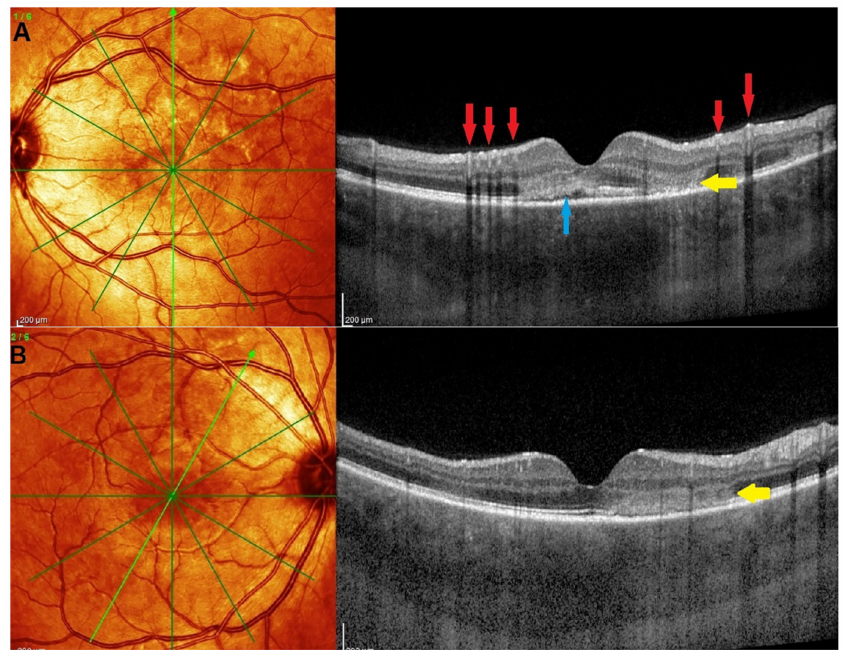
Figure 10. OCT of a patient with APMPPE. ( A ) OCT of left eye: Ischemia of outer retina is presented as an hyperreflective lesion (yellow arrow). A zone of subretinal fluid is also detected (blue arrow). Dilatation of inner retinal vessels leaving a shadow (red arrows). ( B ) OCT of the right eye also showed an hyperreflective zone in the outer retina (yellow arrow).